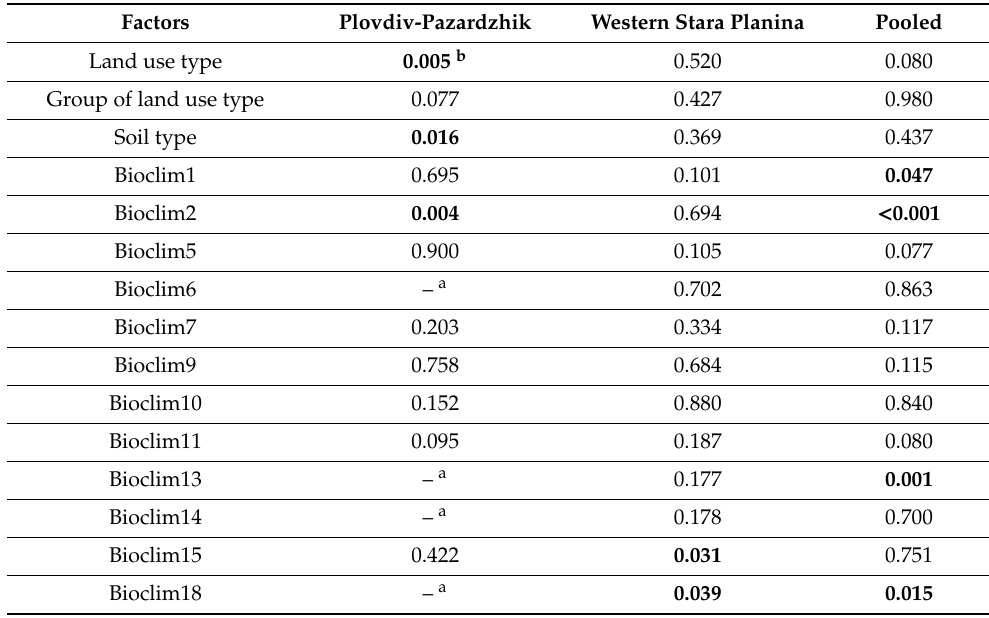
Table 2. Significance of land use type and environmental variables on the plant diversity ( p -values), as determined by linear regression analysis.